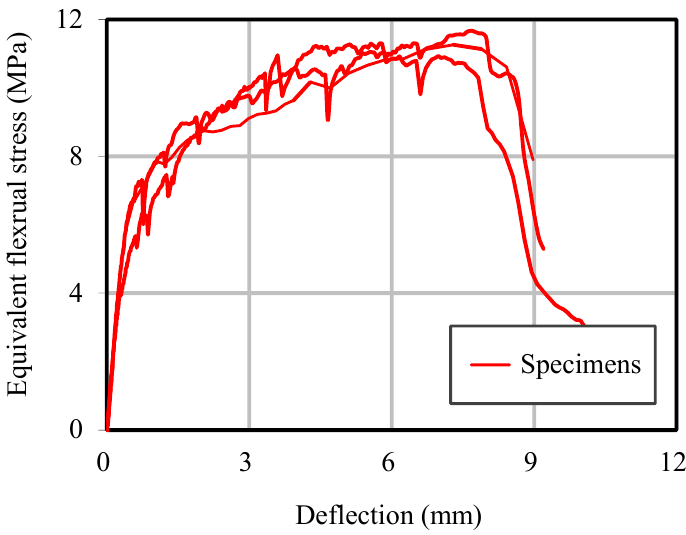
Figure 5. Flexural deformation of HPFRCC.